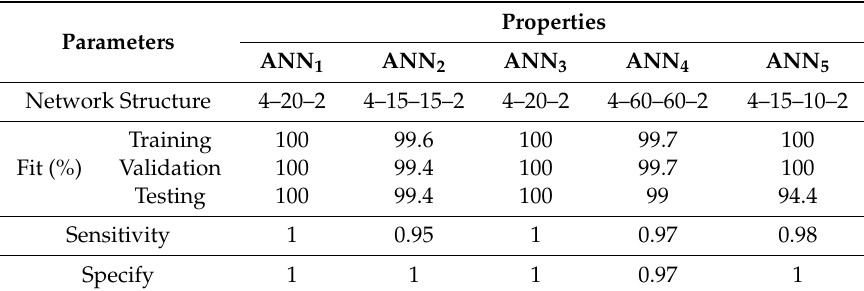
Table 2. ANN properties for OAA ANNs